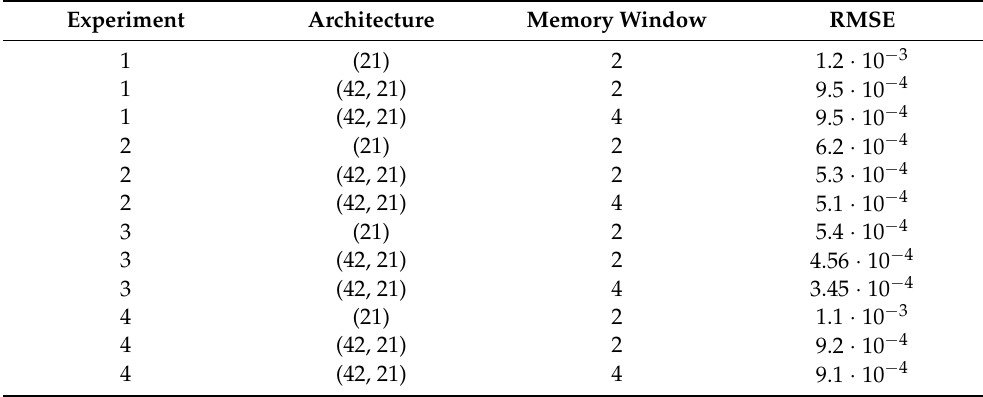
Table 6. Comparison of the different architectures used in this work. The inputs for all architectures are the outputs of the four autoencoders’ (features) and the number of the hole made by the